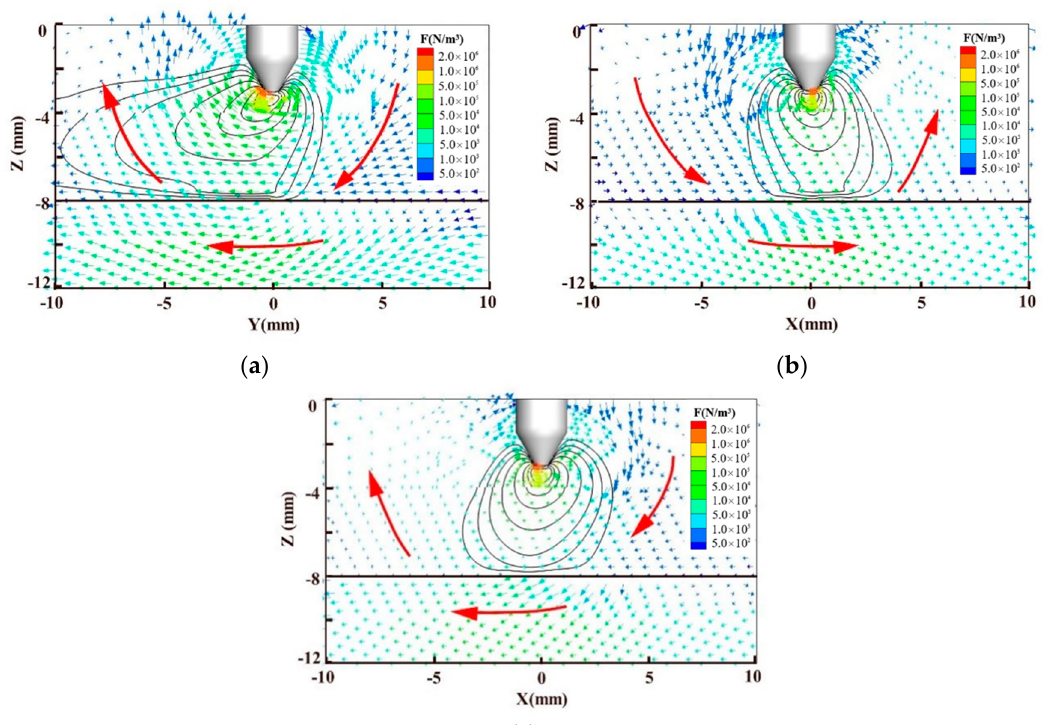
Figure 14. Additional electromagnetic force: ( a ) I e = 3 A, t = t 1 ( yoz plane), ( b ) I e = 3 A, t = t 1 ( xoz plane), and ( c ) I e = 3 A, t = t 2 ( xoz plane).